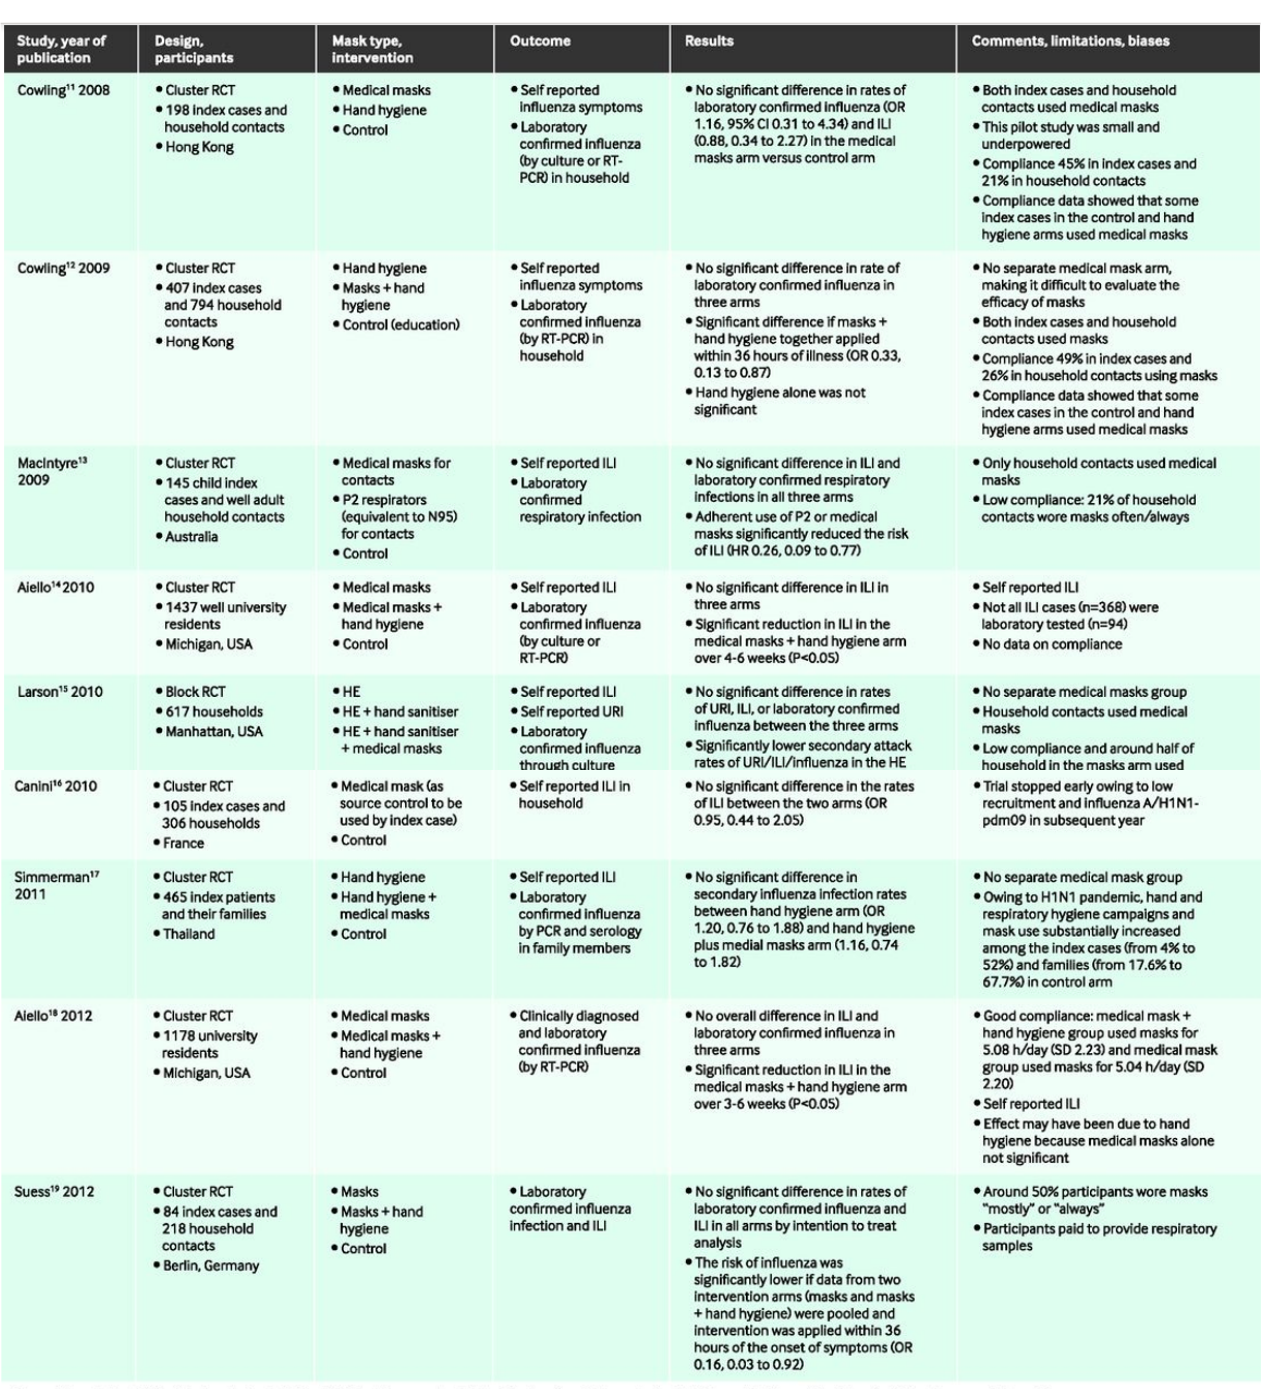
Table 2. Summary of high level evidence (GRADE guidelines) on facemasks in the household setting (from: Raina MacIntyre, and Abrar Ahmad Chughtai